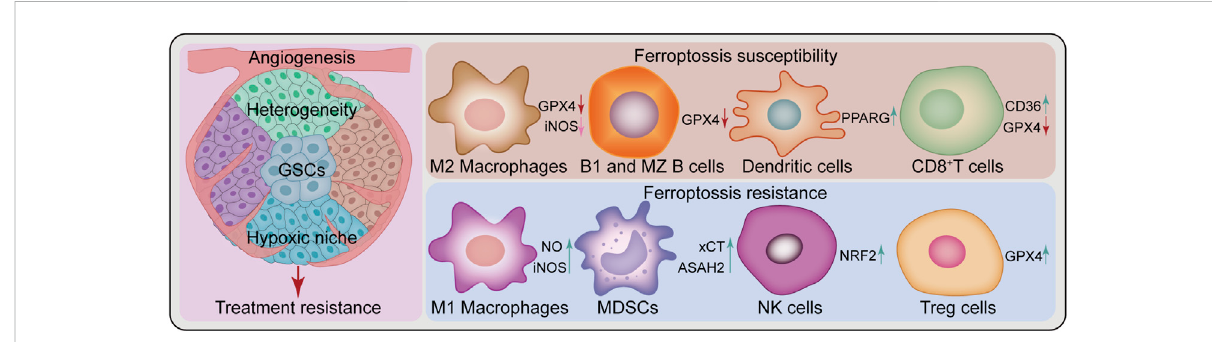
FIGURE 3 Challenges of ferroptosis in GBM treatment. Ferroptosis in glioblastoma treatment faces several challenges, such as heterogeneity, glioblastoma stem cells (GSCs), angiogenesis, hypoxic niche and a complex immune microenvironment composed of various immune cells. Peritumoral immune cells can be either sensitive or resistant to ferroptosis. Some cell types are sensitive to ferroptosis, such as M2 Macrophages, B1 and marginal zone (MZ) B cells, dendritic cells, and CD8 + T cells, while others show resistance, such as M1 Macrophages, myeloid-derived suppressorcells(MDSCs),naturalkillercellsandTregcells.ASAH2,N-AcylsphingosineAmidohydrolase2;CD36, CD36molecule;GPX4, glutathione peroxidase 4; iNOS, inducible nitric oxide (NO) synthase; NRF2, nuclear factor E2-related factor 2; PPARG, peroxisome proliferator-activated receptor gamma; xCT, SLC7A11, solute carrier family 7 member